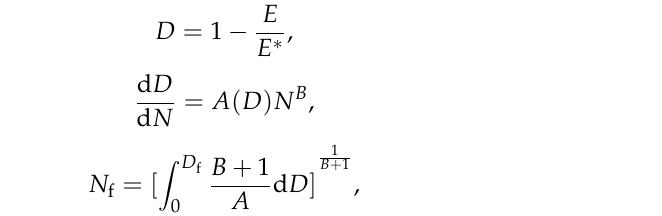
Figure 6. Comparison between a composite and a metal based on cumulative damage [23].